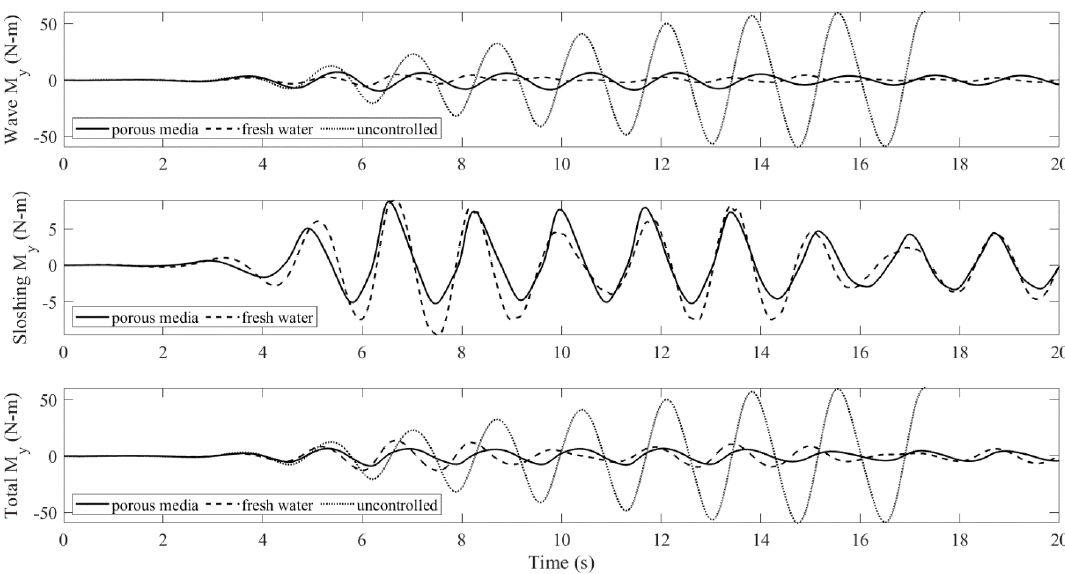
Figure 28. The overturning moments act on the controlled and uncontrolled floating bodies for the large-wave case.